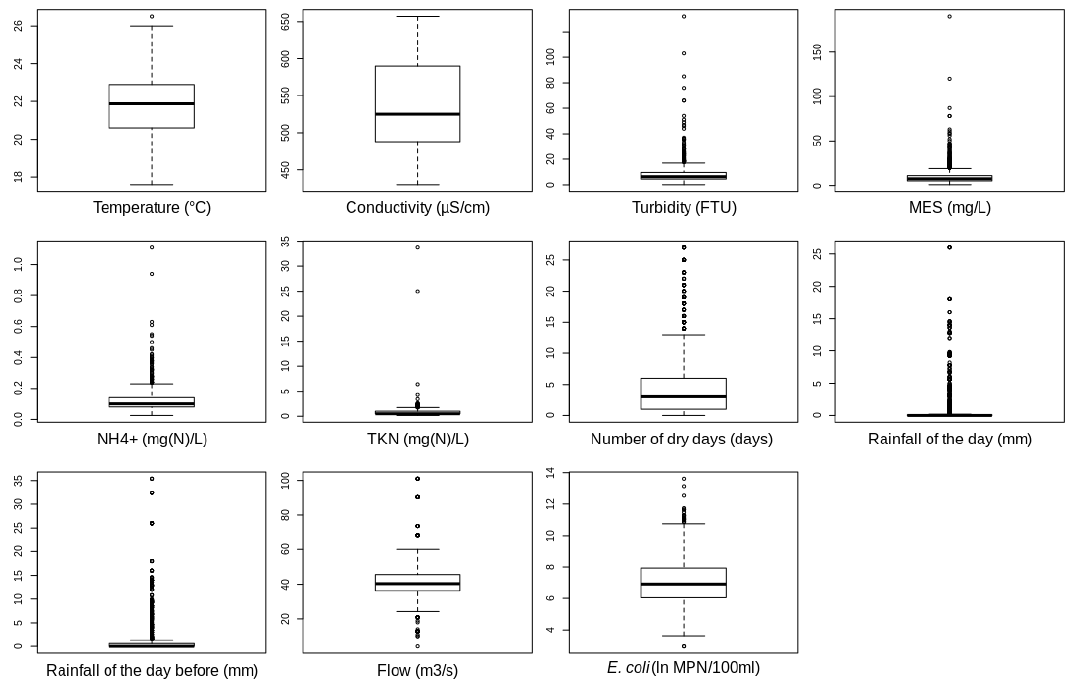
Figure 3. Distribution of the data for each variable. The median is indicated as a solid black line inside each boxplot, outliers are indicated as black dots. On the ordinates are the values taken by each variable with the units specified in parenthesis. The concentration of E. coli (4337.61 ± 25,983.50 MPN/100 mL) measured during